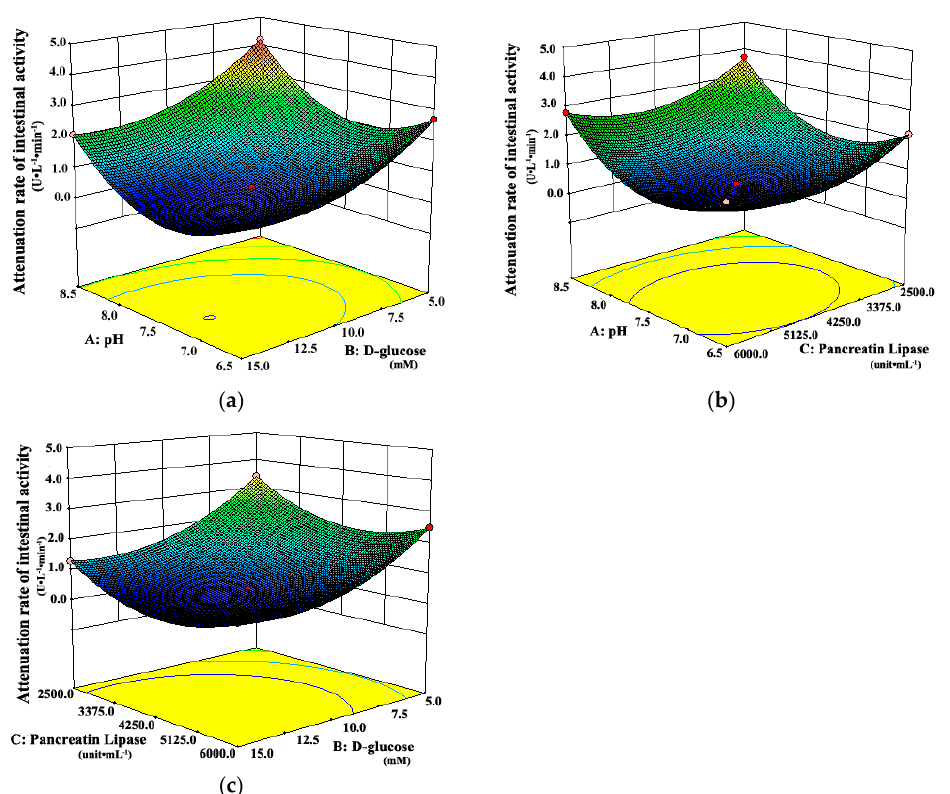
Figure 3. Response surface plots showing interaction effects of pH, D -glucose, and pancreatic lipase on the attenuation rate of intestinal tissue activity when ( a ) pancreatic lipase, ( b ) D -glucose, and ( c ) pH held constant, respectively.